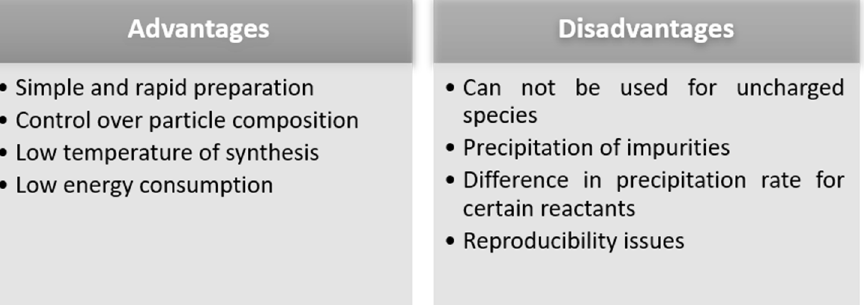
Figure 6. Advantages and disadvantages of co-precipitation method.